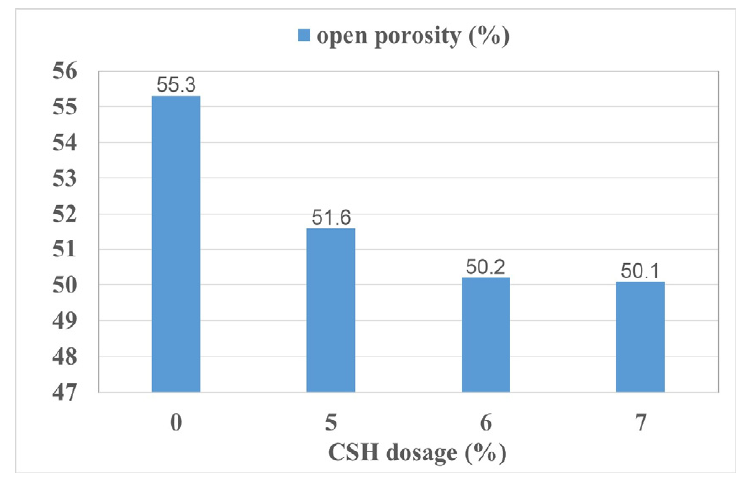
Figure 9. The open porosity change in bone with consolidation by CSH.